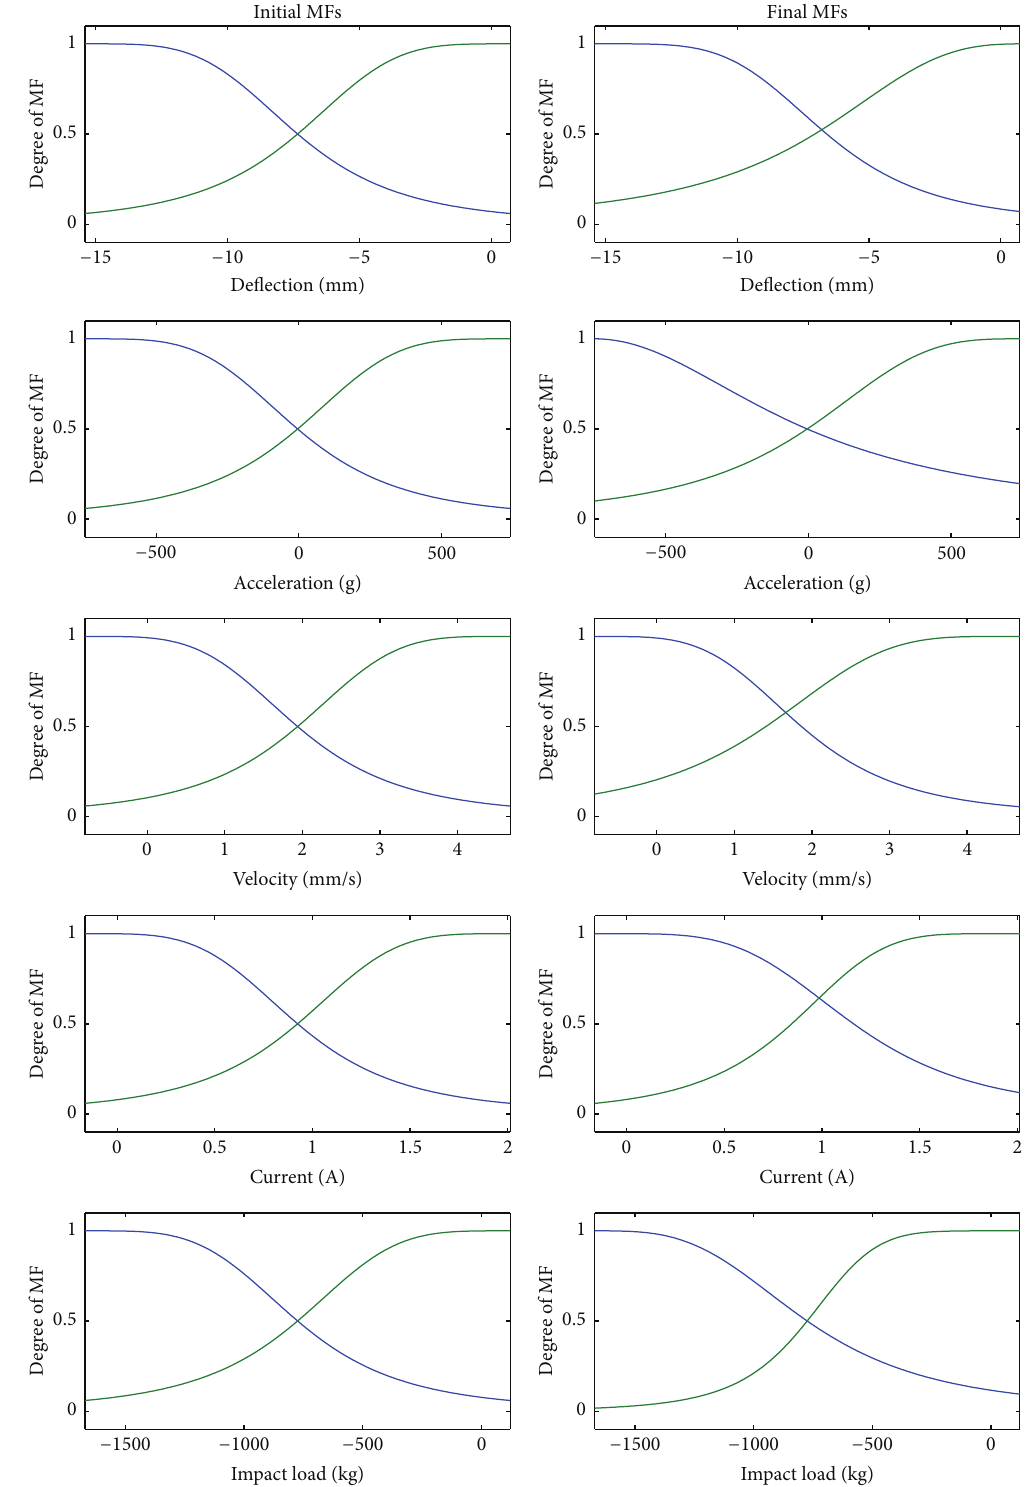
Figure 17: Initial and final membership